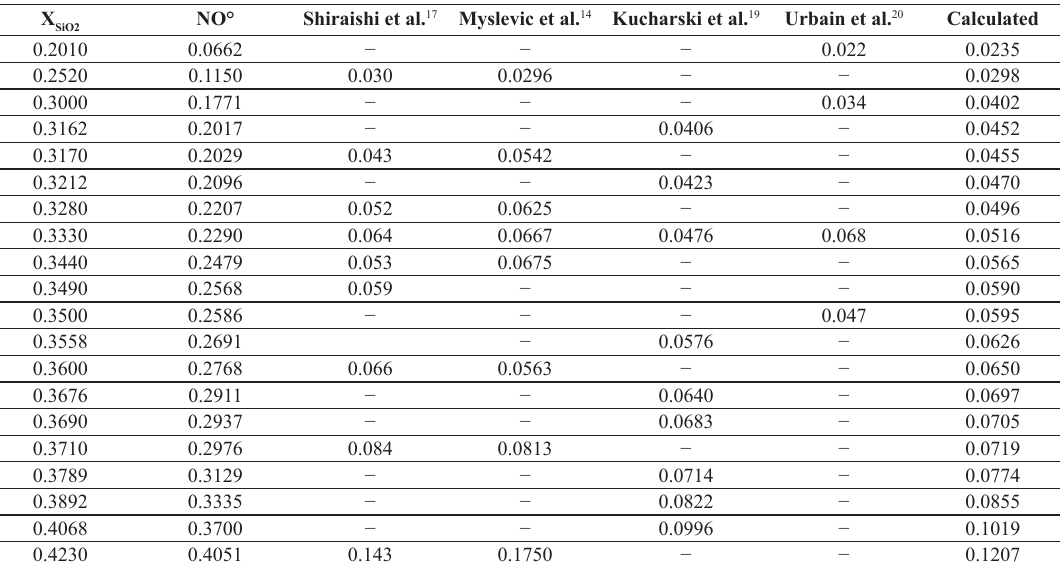
−FeO system at 1573 K, in Pa ⋅ s. 2